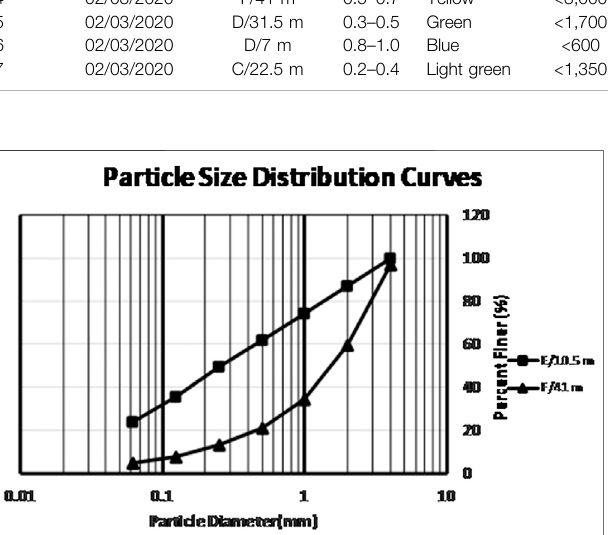
FIGURE 7 | Typical particle-size distribution curves in the study site.